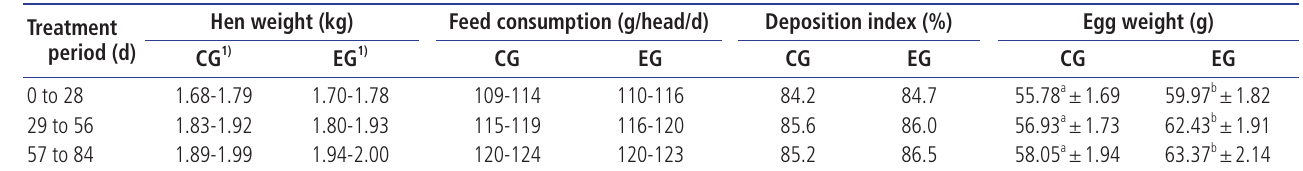
Table 2. Productive parameters evaluated during the experimental period on the group of animals fed with a standard diet and those fed a supplementation of extruded linseed Treatment period